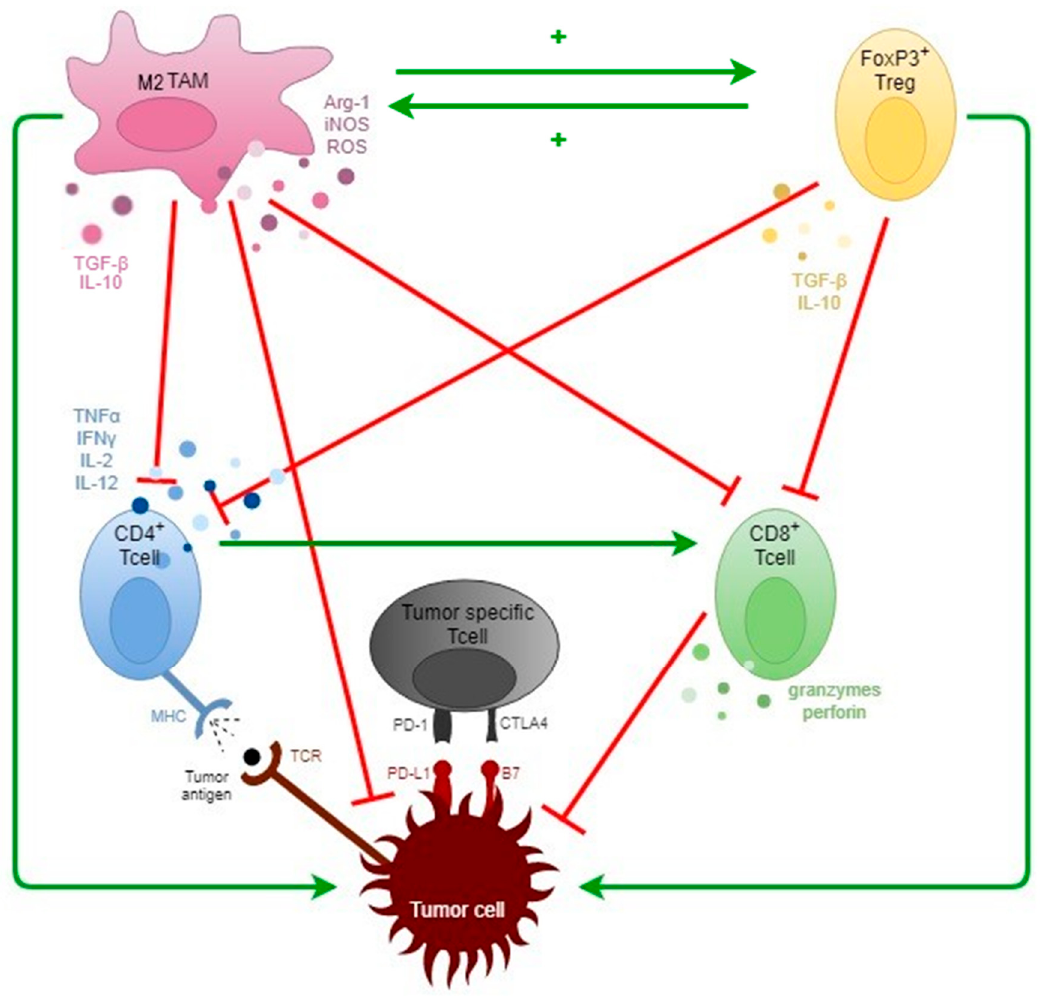
Figure 1. A simplified overview of interactions between tumor cells and TME-associated immune cells. CD4 + (FoxP3 − ) and CD8 + T cells are designed for tumor cell elimination, though their function can be altered by recruitment of pro-tumorigenic (M2) TAMs and FoxP3 + Treg, who interact in a positive feedback-loop. TNF α = Tumor necrosis factor alfa. TGF β = Tumor growth factor Beta; IL = Interleukin; IFN γ = Interferon gamma; Arg1 = Arginase 1; iNOS = inducible nitric oxide synthase; ROS = reactive oxygen species, PD-1 = programmed death 1, PD-L1 = programmed death ligand 1, CTLA-4 = cytoxic T-lymphocyte associated protein 4, MHC = major histocompatibility complex, TCR = T cell receptor.